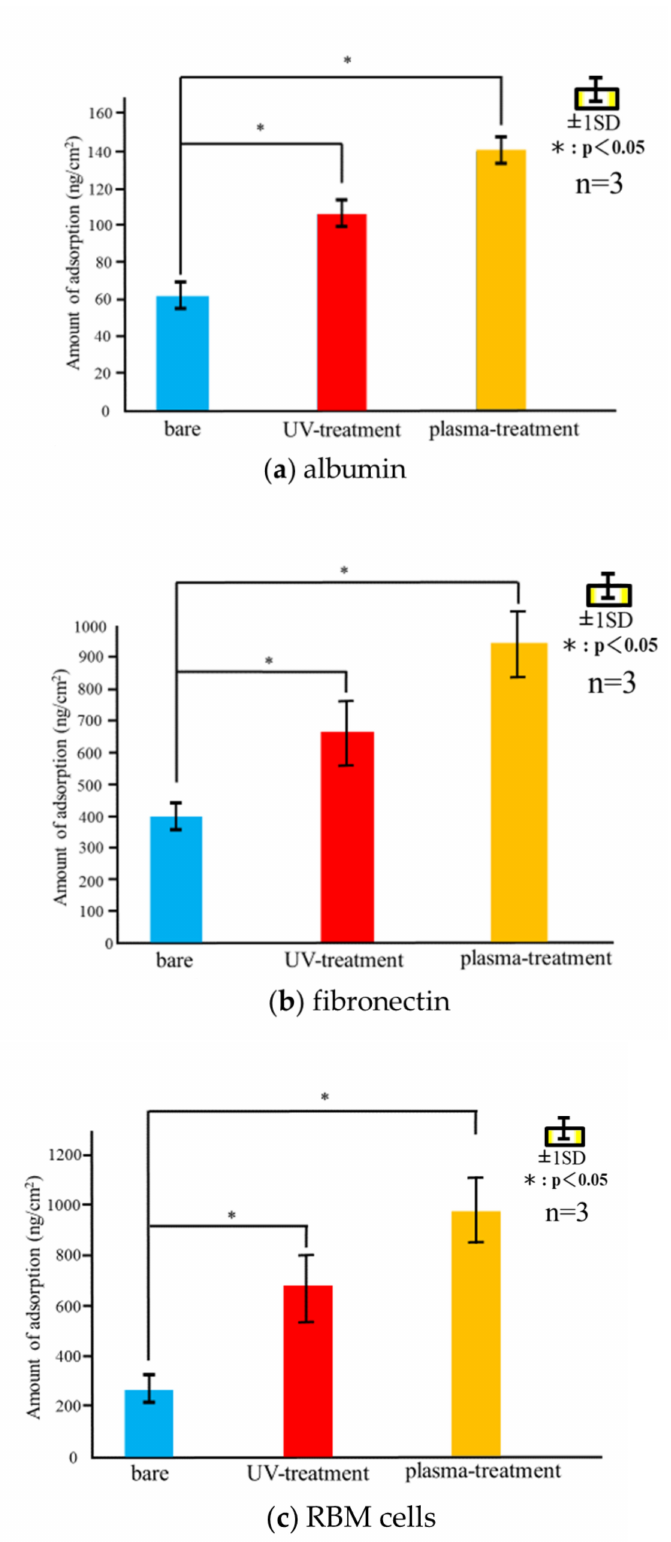
Figure 6. Final adsorption weights of ( a ) albumin, ( b ) fibronectin, and ( c ) RBM cells on the three sample types after 60 min